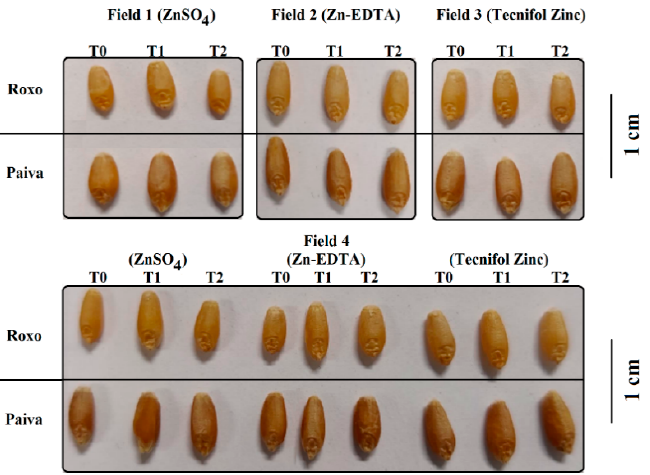
Figure 3. Macroscopic aspects of Triticum aestivum L. grains, of each treatment of Roxo and Paiva varieties, from the experimental fields 1–4. For the same fertilizer (ZnSO 4 , Zn-EDTA and Tecnifol Zinc): T0 = control; T1, T2 correspond, respectively, to initial and upper